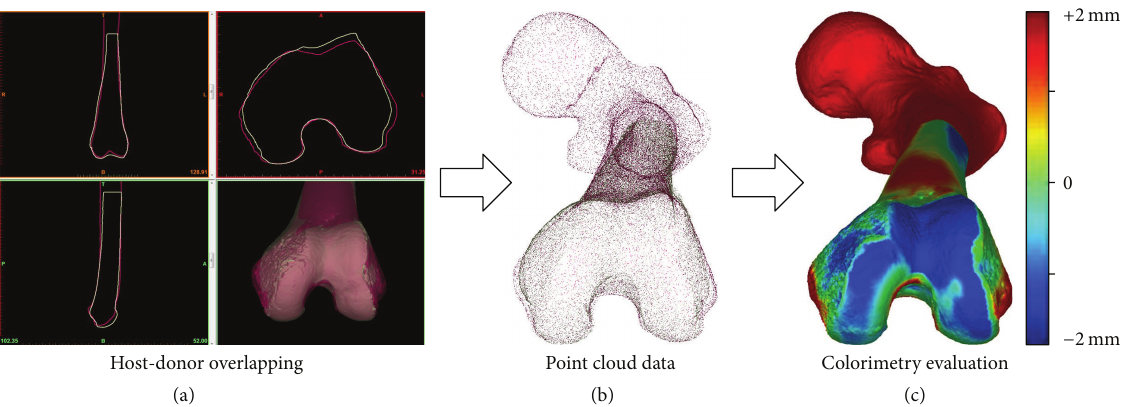
Figure 3: (a) Host and donor were overlapped in a virtual platform in order to compare the best match according to the shapes. (b) 3D models were exported to point cloud data. (c) A colorimetry evaluation was applied comparing host and donor surfaces.